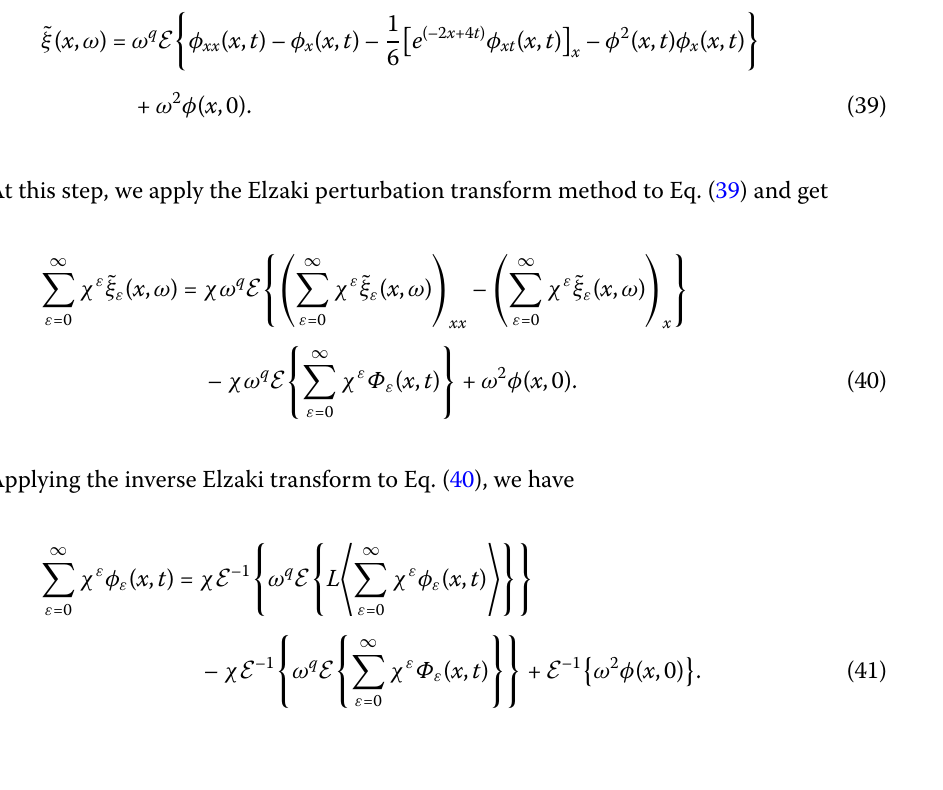
observed that for the AB operator the wave damping is slower than for the Caputo oper-